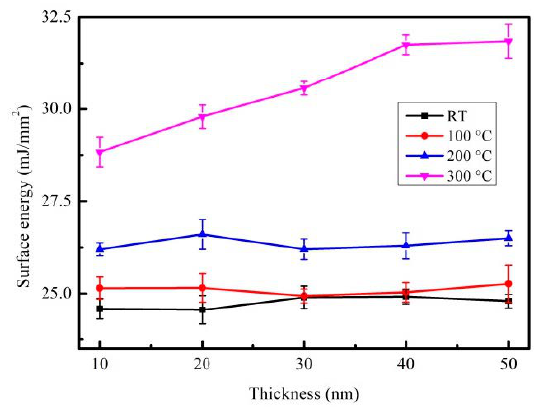
Figure 7. Surface energy of CoFeBY thin